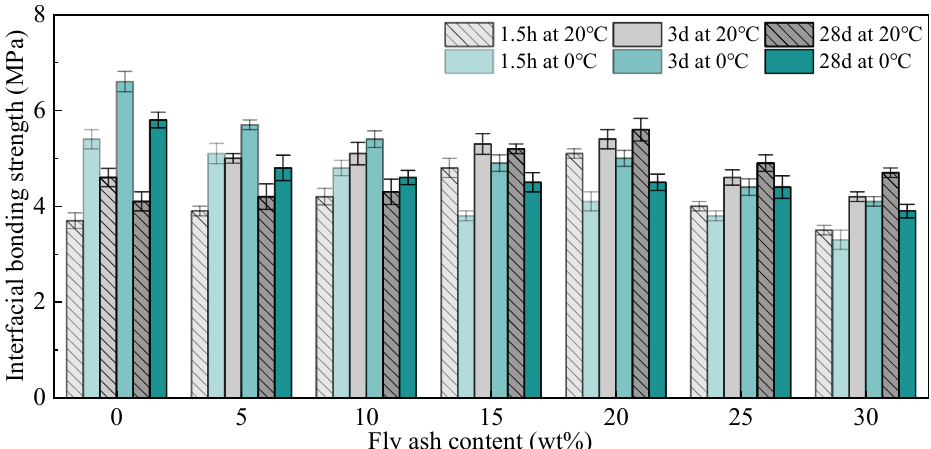
Figure 7. The variation of interfacial bonding strength with mixing temperature and fly ash content.